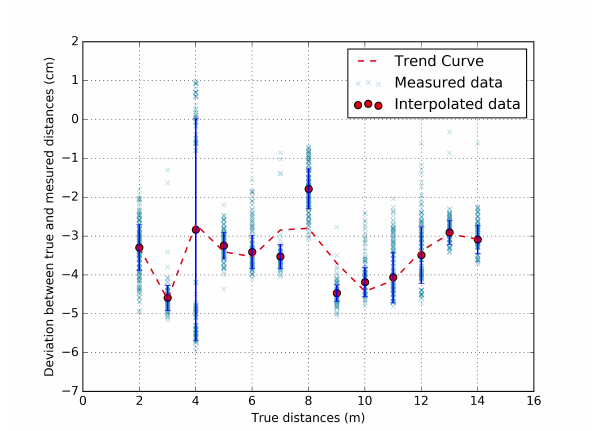
Figure 9: Deviations of measured distances with respect to true distances (indoor)